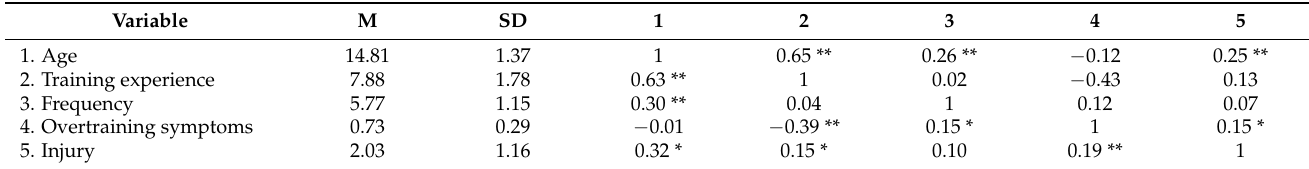
Table 1. Descriptive statistics and correlations between study